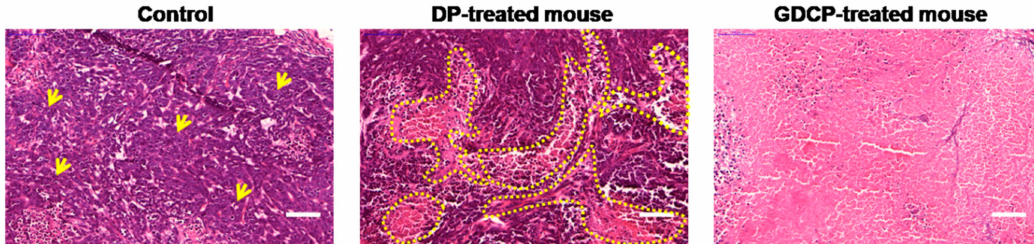
Figure 7. H&E-stained slides of cancers extracted at Day 7 from normal, cancer-bearing, and GDCP hydrogel-treated mice. In the control, clustered cancer cells were generally observed; on the other hand, in the DP-treated mouse, clustered cancer cells and a necrotic area were partially observed. Overall, necrotic area was observed in GDCP-treated mouse. Yellow arrows indicate typical clustered cancer cells. Yellow dotted lines indicate necrotic area. Scale bar indicates 100 µ